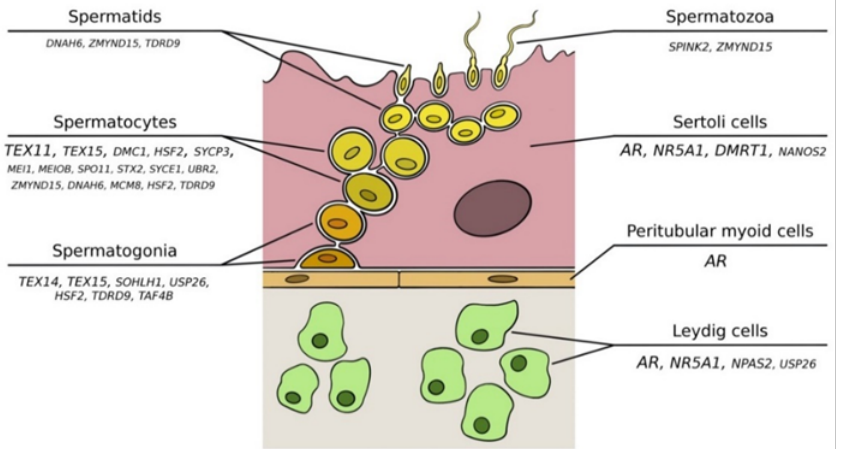
Figure 1. Schematic illustration of spermatogenesis. Genes with reported mutations associated with nonobstructive azoospermia are shown in the cells in which they are expressed. The font size correlates with the strength of the